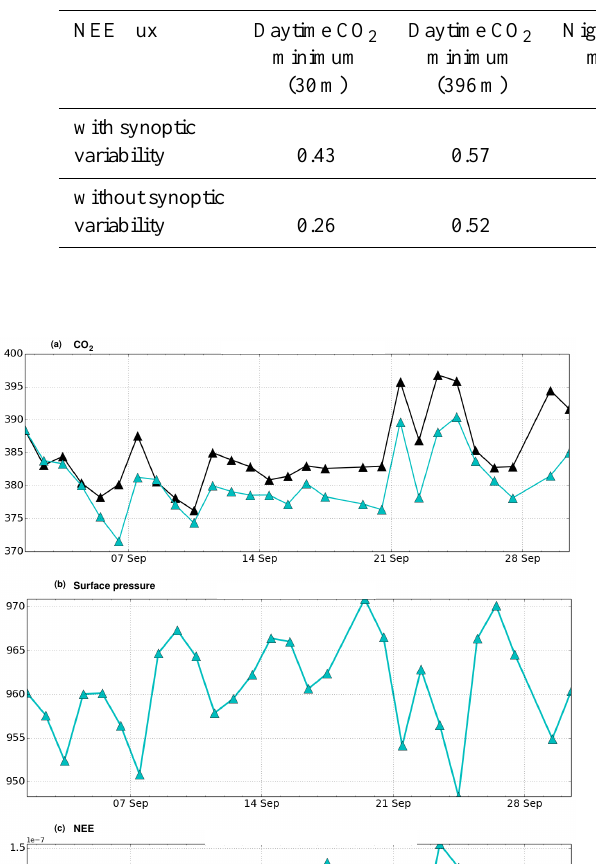
Table 4. Correlations between de-trended hindcast and observed CO 2 at two different levels of the Park Falls tall tower showing the impact of synoptic variability of NEE on the atmospheric CO 2 hindcast.